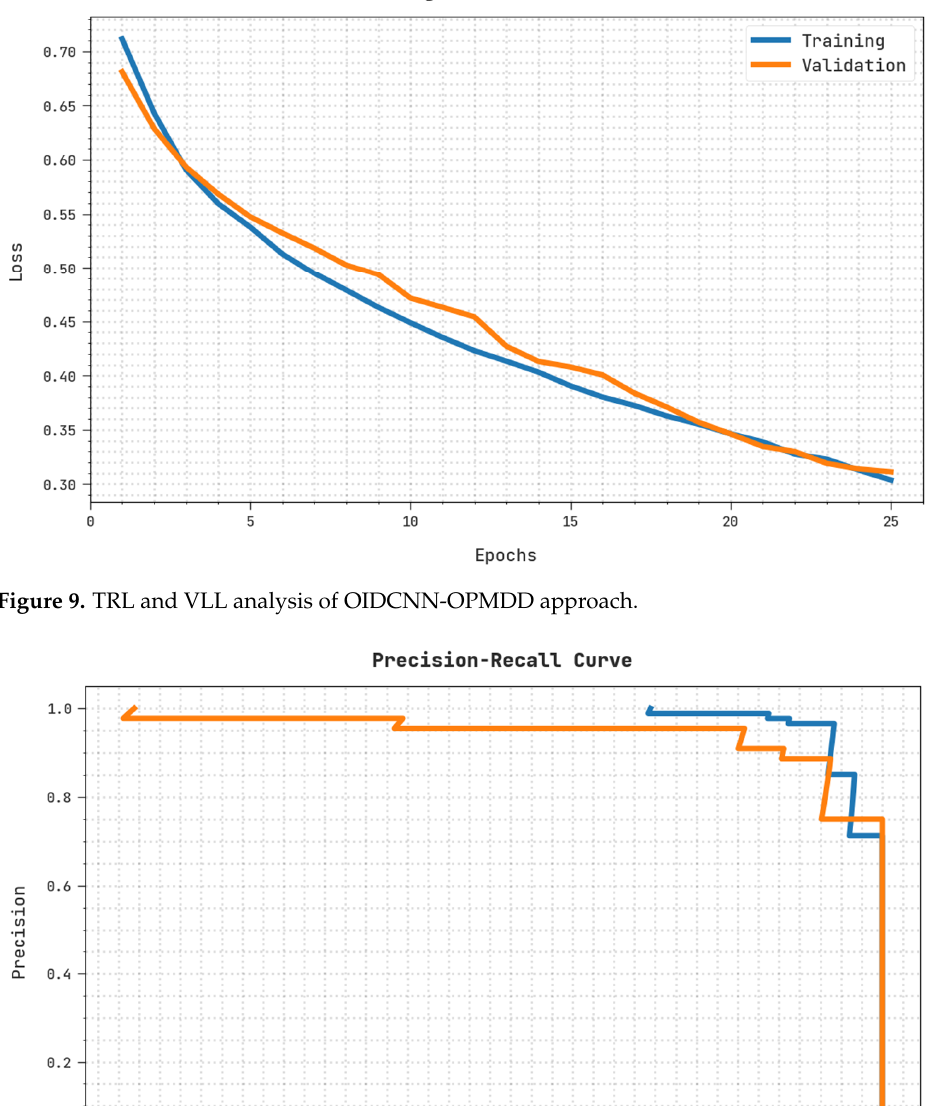
Figure 10. Precision–recall analysis of OIDCNN-OPMDD approach.